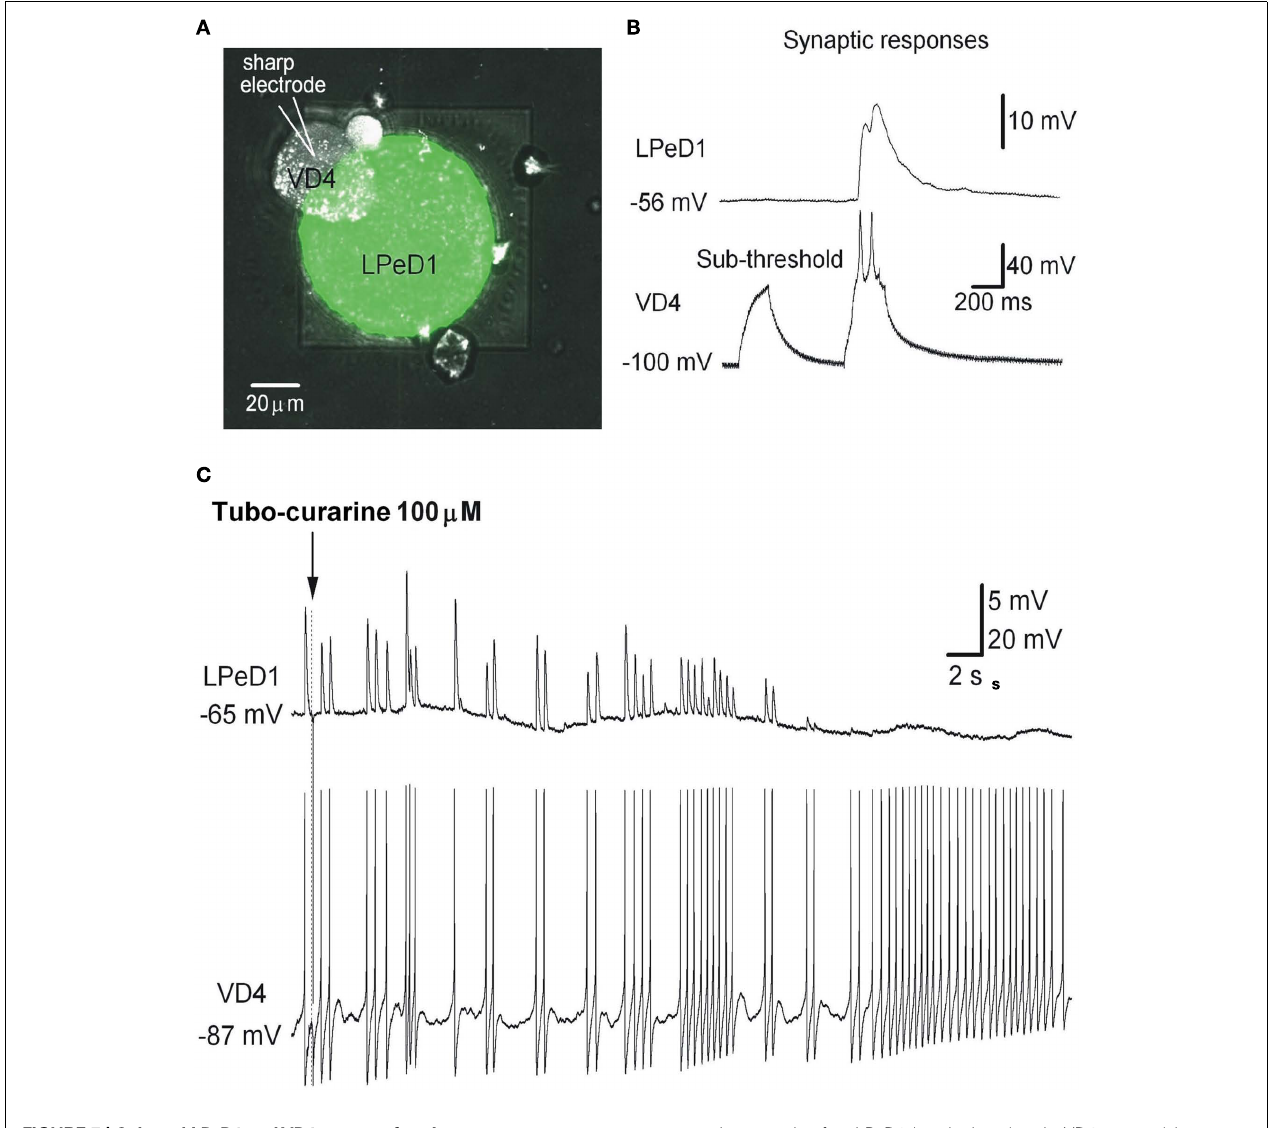
FIGURE 7 | Cultured LPeD1 andVD4 neurons forming a soma–soma synapse on a Si chip. (A) Superposition of reflected light and fluorescence confocal imaging of a Si chip with an LPeD1 neuron plated over the aperture and forming a soma–soma synapse with aVD4 neuron. Subterranean fluidics were filled with a recording solution containing a green dye. (B) Simultaneous whole-cell recordings in